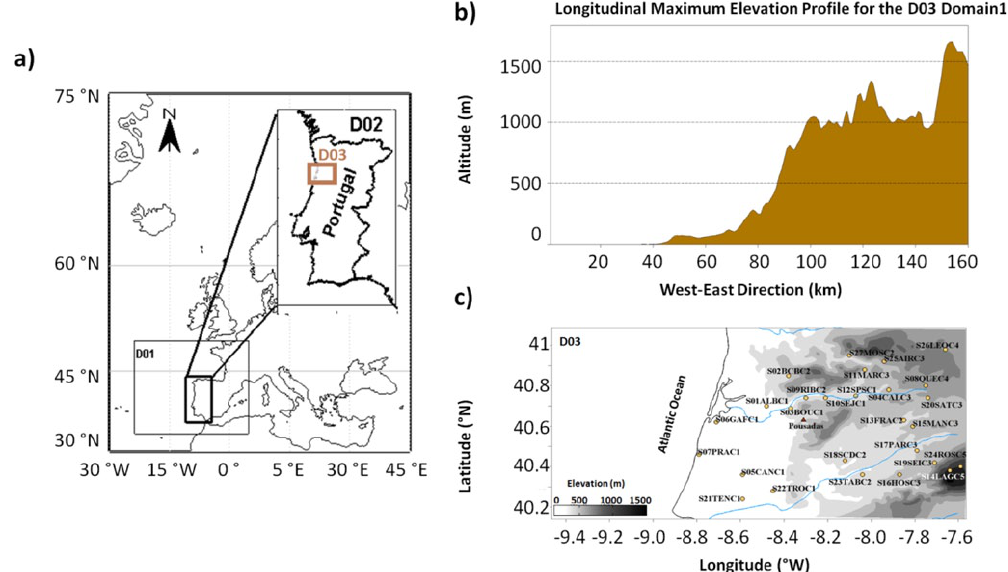
Fig. 1. Study area and stations location over the study area. (a) Nested domains for the WRF model experiments showing the outermost do- main (D01) with 25-km resolution, the middle domain (D02) with 5km of resolution and the innermost domain (D03) with 1-km resolution. The D03 frame marks the study area; (b) longitudinal maximum elevation profile for the 1-km domain; (c) location of the rain-gauge stations (yellow dots) over the 1-km domain and the location of Pousadas (red